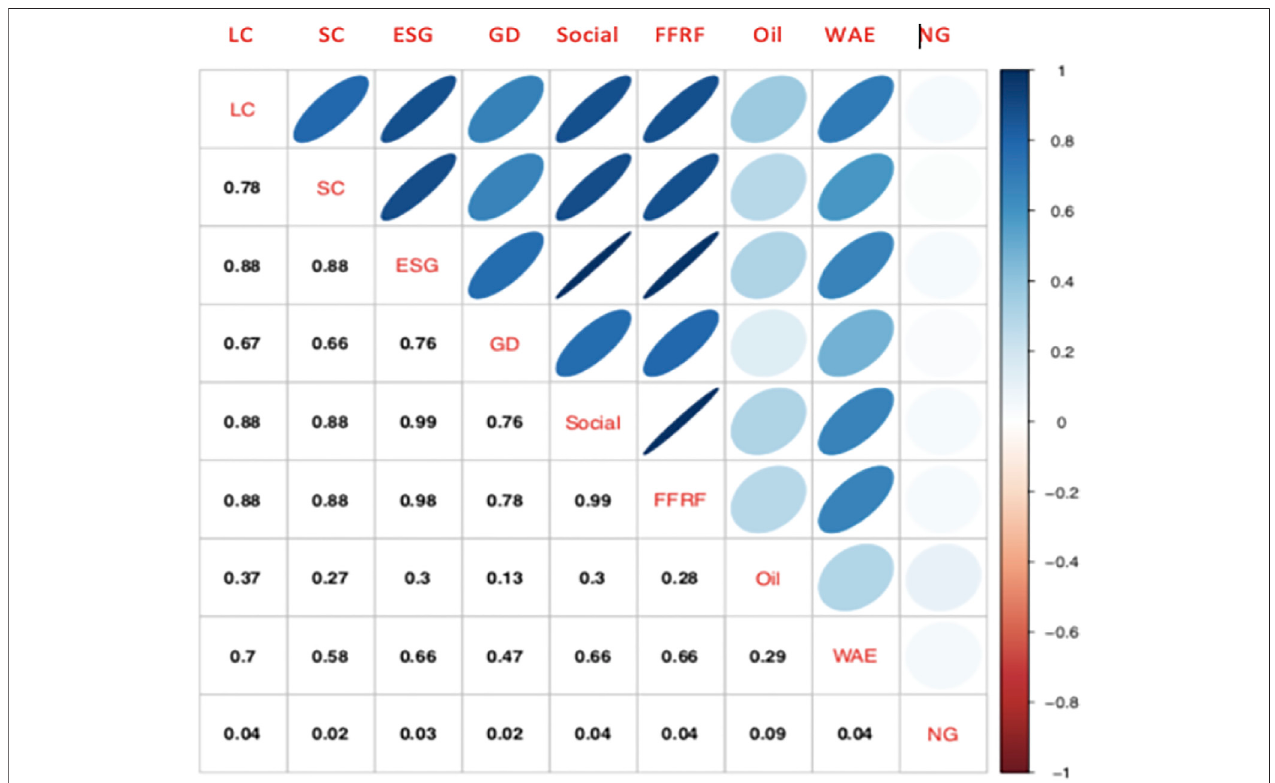
FIGURE 2 | Unconditional returns